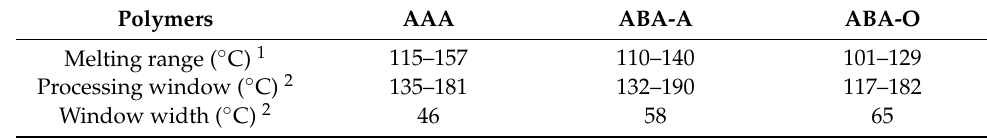
Figure 4. Typical photos of the dissolution states of three polymers in several solvents. Table 3. The melting ranges, processing windows and window widths of three